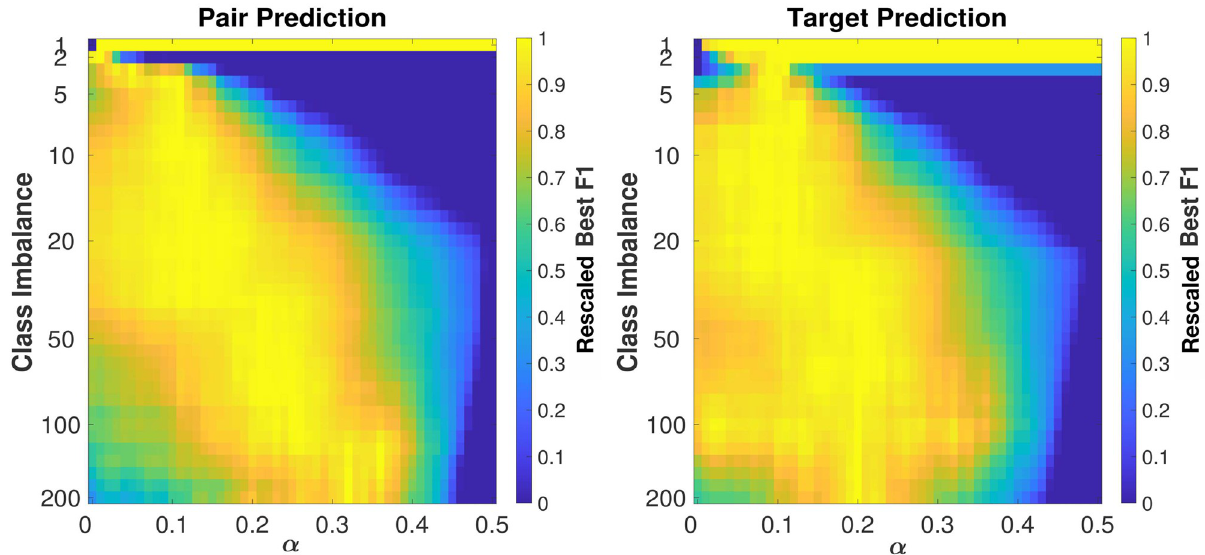
Fig 3. Dependence of maximum Best F1 on α and the class imbalance in the Jaffe + Sectors measure. For each value of class imbalance, we rescale the Best F1 between 0 and 1 to better visualize the maximum as a function of α . The maximum F1 moves towards higher α values when the class imbalance increases. This suggests that when choosing a M&A pair among a large pool of options, the industrial sector plays a more important role.